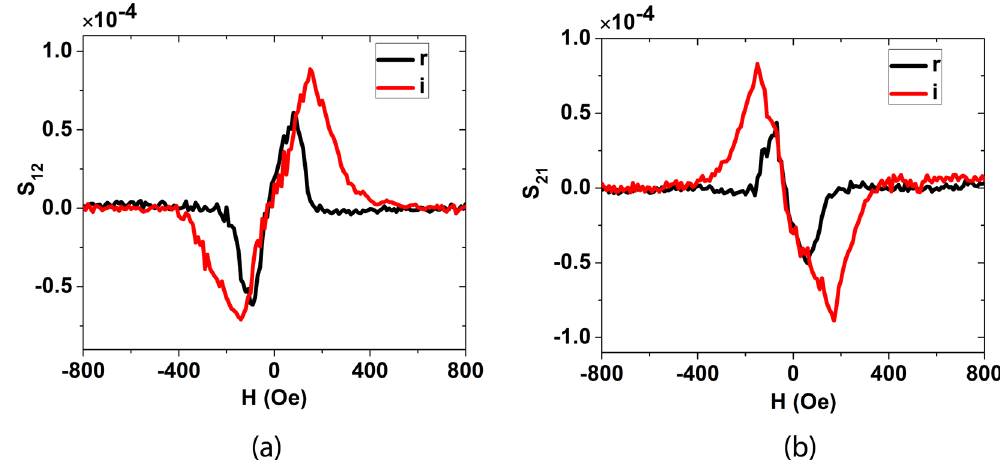
Figure 3. SAW generation: the field was applied at an angle of 45° for all these measurements. ( a ) Real and imaginary parts of S 12 . ( b ) Real and imaginary parts of S 21